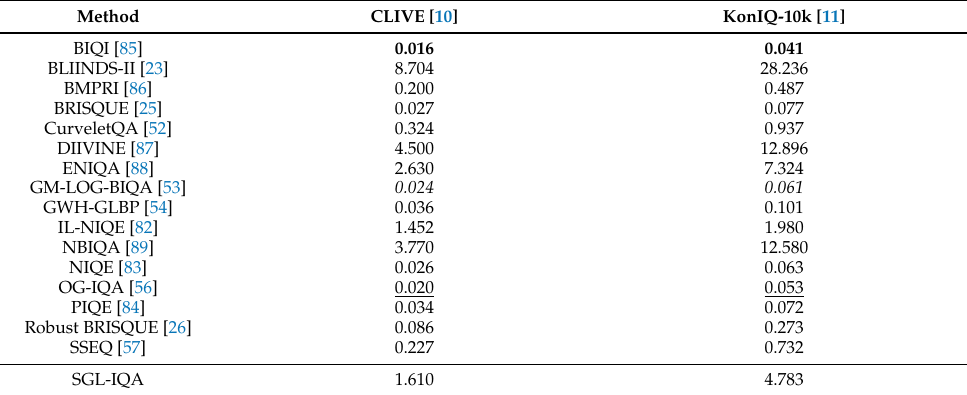
Table 12. Feature extraction times (given in seconds) on CLIVE [10] and KonIQ-10k [11]. The best results are given in bold, the second-best results are underlined, and the third-best results are given in